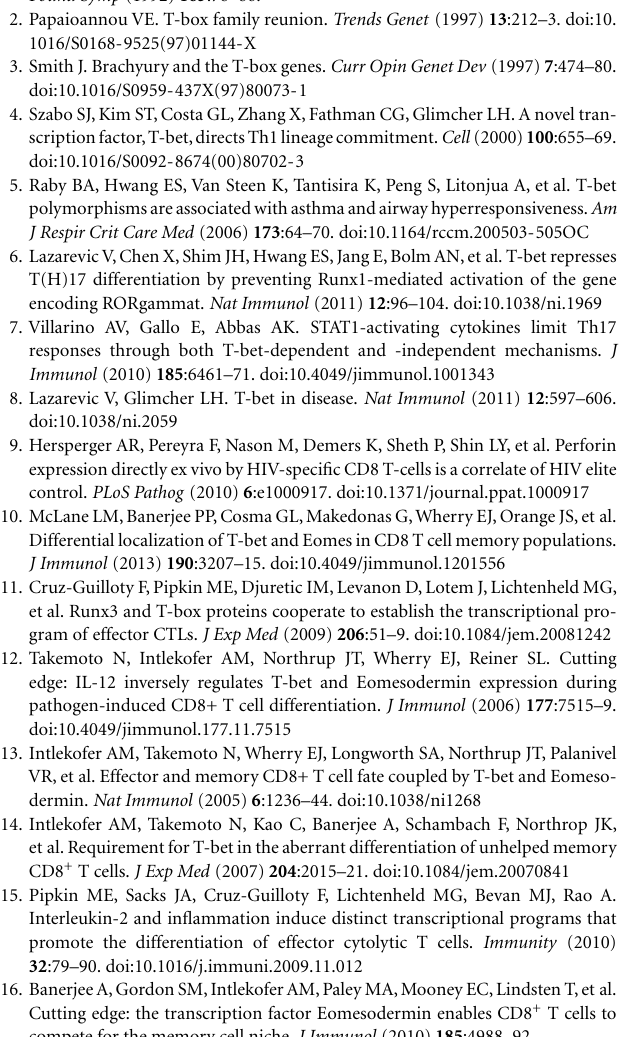
Figure S1 |T-bet and Eomes expression in CD8 + and CD4 + T-cell memory populations. (A–D) T-bet and Eomes expression in CD8 + T-cells. (A) The frequency of CD8 + T-cell memory populations within total CD8 + T-cells is shown. Populations were defined as described in the text using the memory markers CCR7, CD45RO, and CD27. (B) Box and whisker graphs displaying the frequency